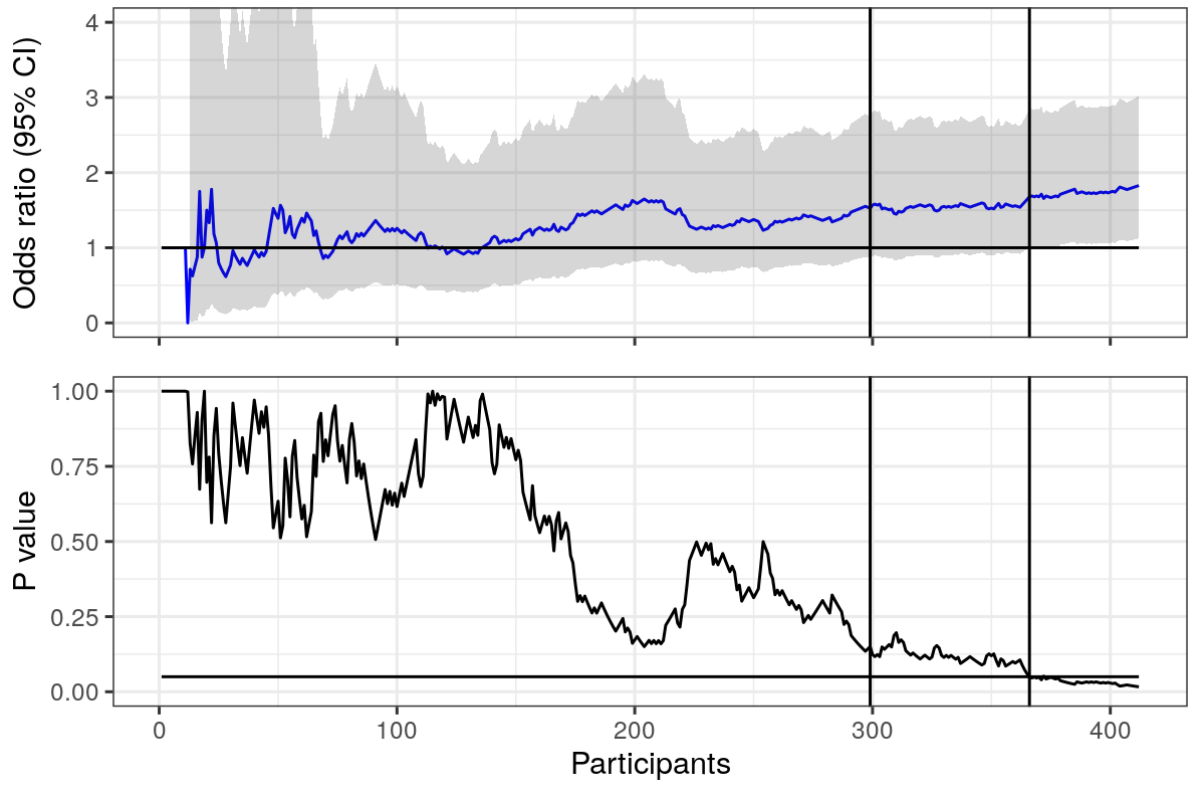
Figure 2. Point prevalence: odds ratios and P values calculated using actual data from trial, plotted over time (number of responders in the study). Horizontal lines represent null value (OR 1) and the .05 statistical significance line. First vertical line represents where the first 6 months of recruitment ended, second vertical line represents when point prevalence became statistically